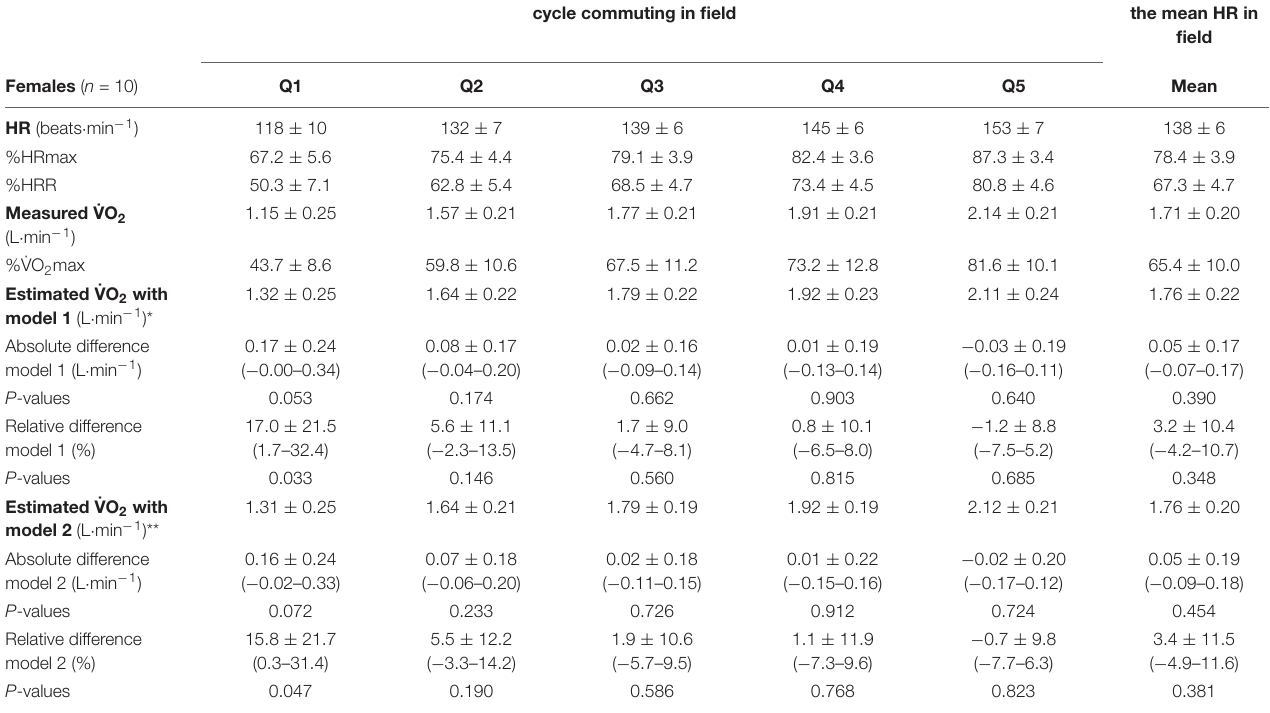
TABLE 5 | The heart rate (HR) spectrum during cycle commuting in field as well as the measured and estimated oxygen uptake (˙VO 2 ) at these positions for females. Values based on the mean HR in size ordered segments of quintiles (Q) of all single HR values during cycle commuting in field